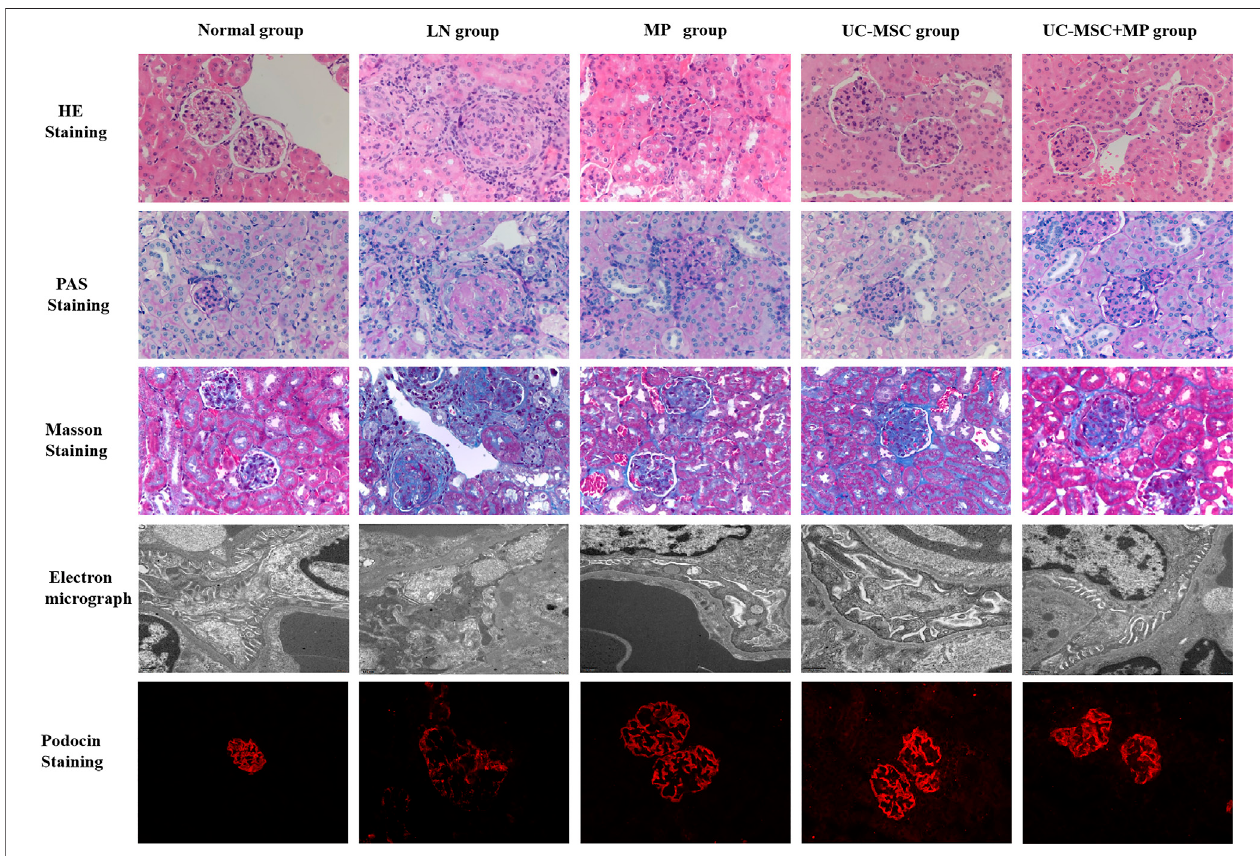
FIGURE 3 | Pathological and electron microscopy results of the renal tissue. HE staining ( fi rst line, ×400), PAS staining (second line, ×400), Masson staining (third line, ×400), electron microscopy (fourth line), and podocin immuno fl uorescence staining ( fi fth line, ×400). Normal group ( fi rst column), LN group (second column), UC- MSC group (third column), MP group (fourth column), and UC-MSC + MP group ( fi fth column).